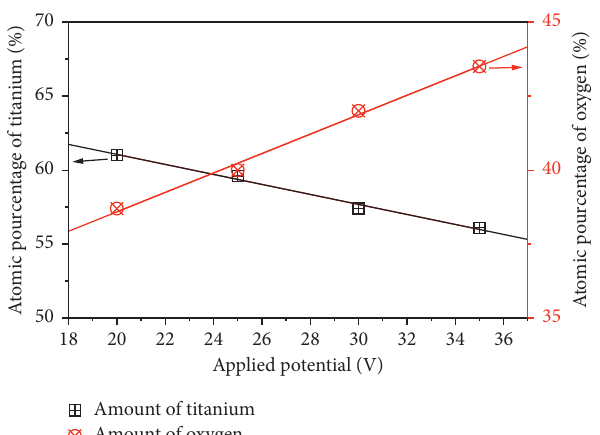
Figure 3: Amounts of titanium and oxygen during 2min at various polarization voltages. Samples anodized at different applied voltage were characterized by X-ray diffraction. Figure 4 illustrates the results.